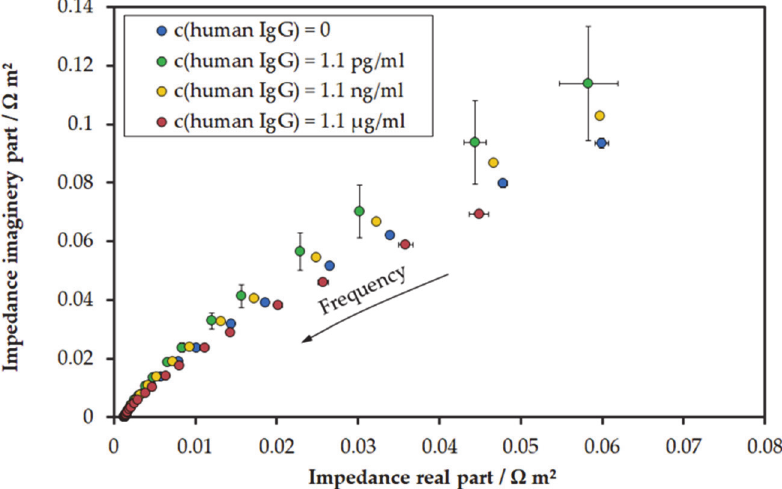
Figure 7. EIS impedance imaginary part over real part (Nyquist plot) for the four different concen-